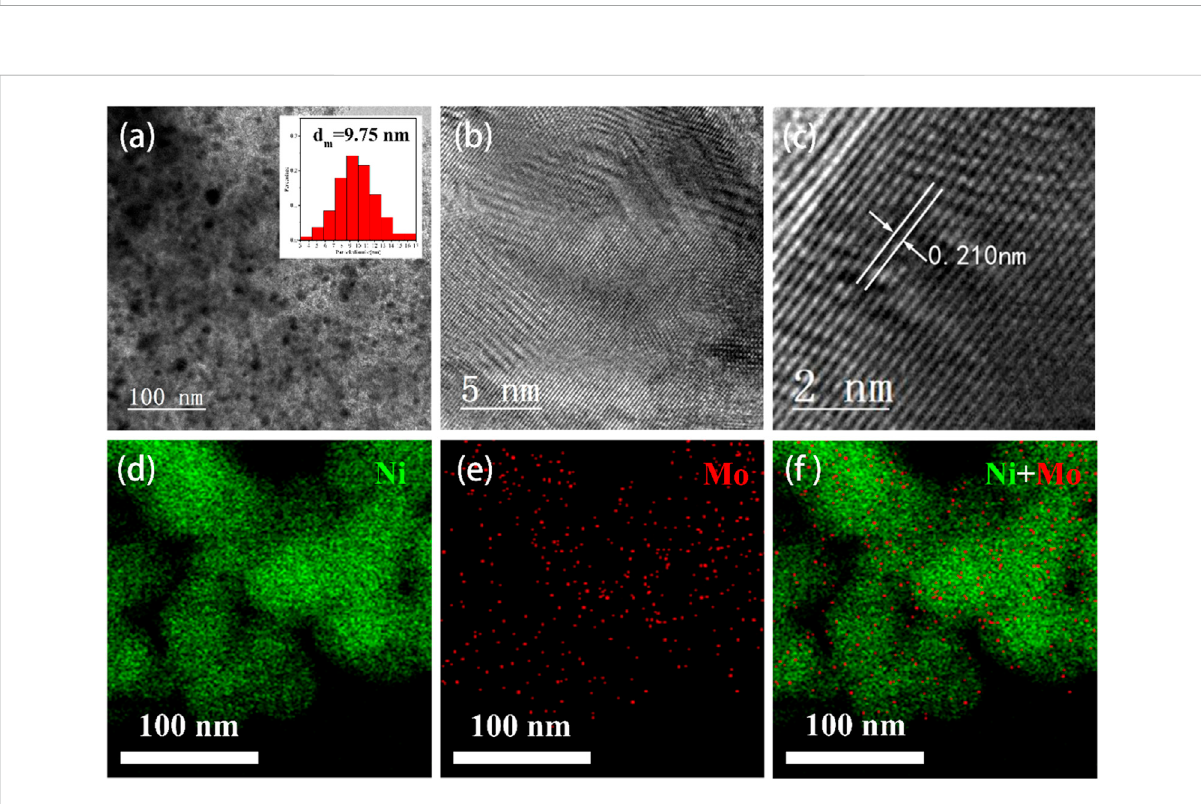
FIGURE 2 Structural characterization of Ni 4 Mo/AC. (A – C) TEM image. (D – F) EDS elemental mapping of Ni and Mo in Ni 4 Mo/AC.